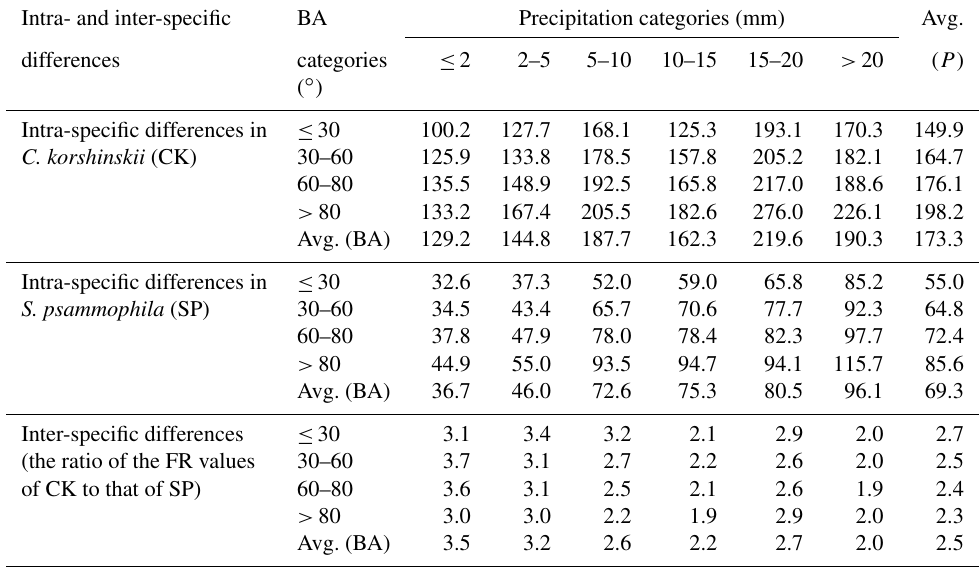
Table 5. Comparison of the funnelling ratio (FR) for the foliated C. korshinskii and S. psammophila . Intra- and inter-specific BA